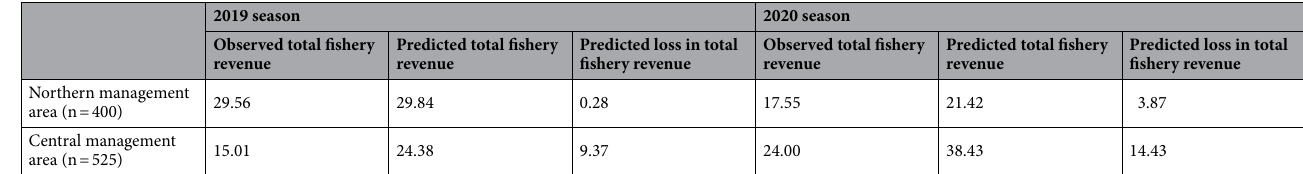
Table 1. Observed, predicted and loss estimate values (million $) for revenues from the Commercial Dungeness crab fishery in California. N represents the number of vessels included in the